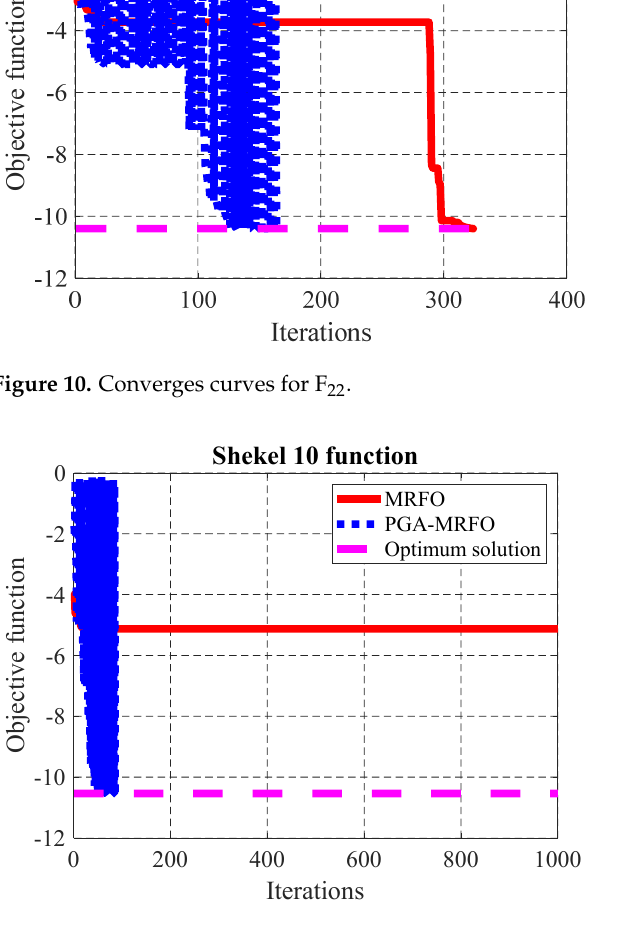
Figure 11. Converges curves for F 23 .